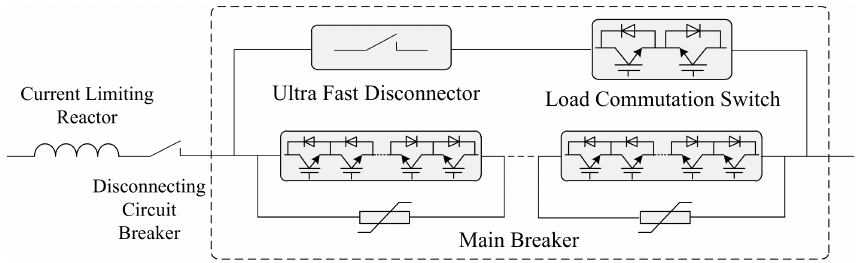
Figure 8. Structure of the hybrid HVDC